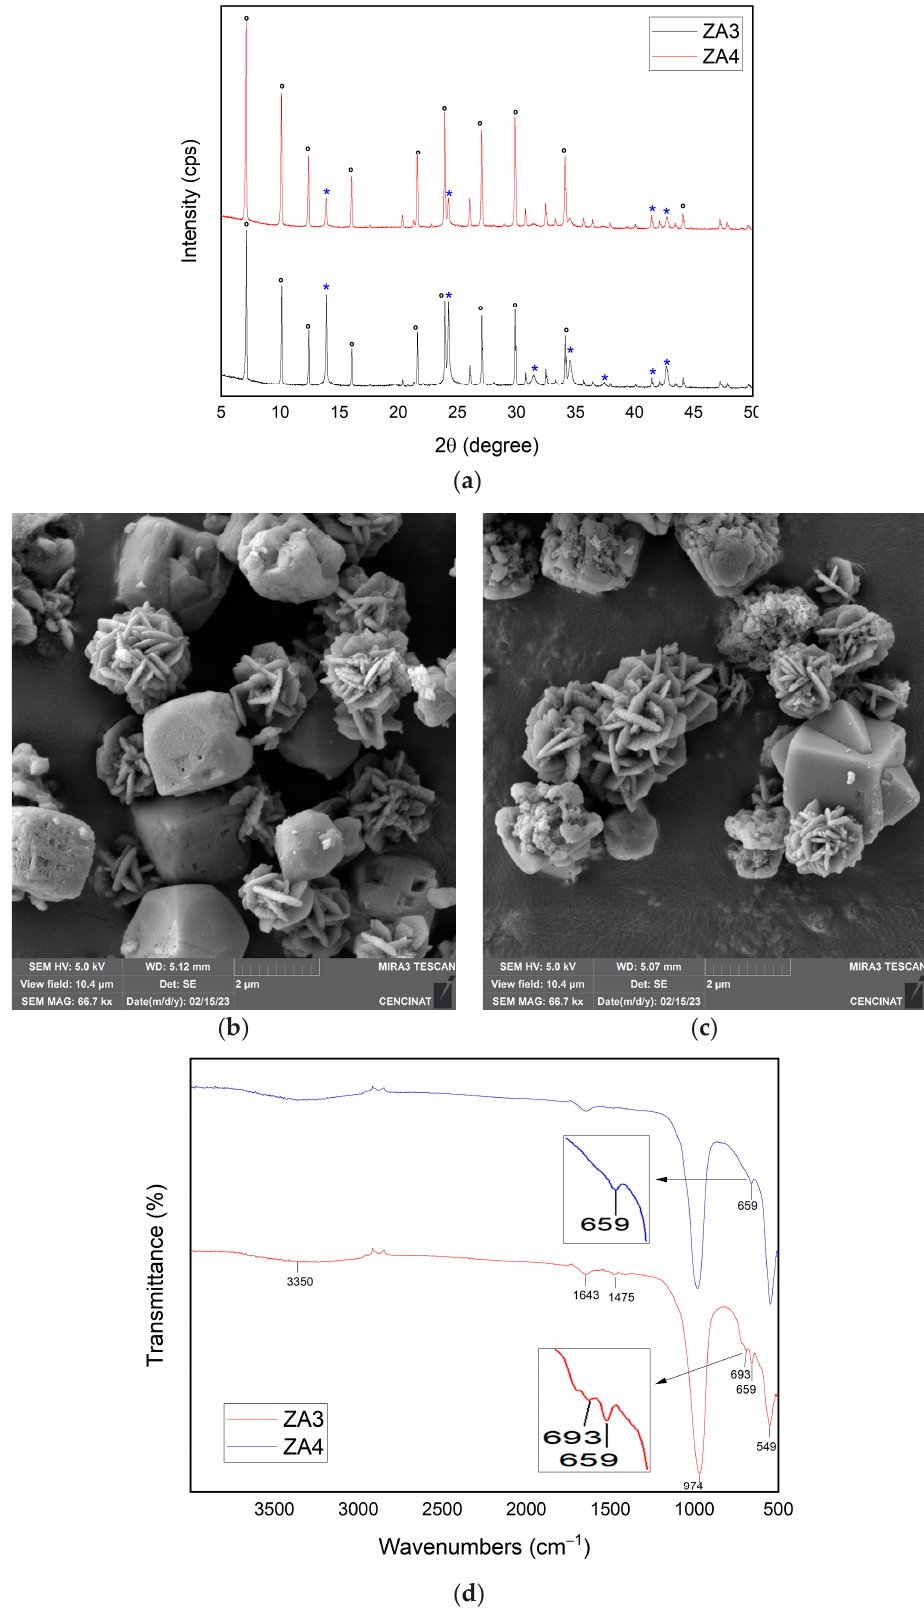
Figure 3. XRD pa tt erns of synthesized zeolites ZA3 and ZA4 ( a ), * sodalite and ° LTA). SEM micro- Figure 3. XRD patterns of synthesized zeolites ZA3 and ZA4 ( a ), * sodalite and ◦ LTA. SEM micro- graphs of ( b ) ZA3 and ( c ) ZA4. FTIR spectra for ZA3 and ZA4 ( d ). graphs of ( b ) ZA3 and ( c ) ZA4. FTIR spectra for ZA3 and ZA4 ( d